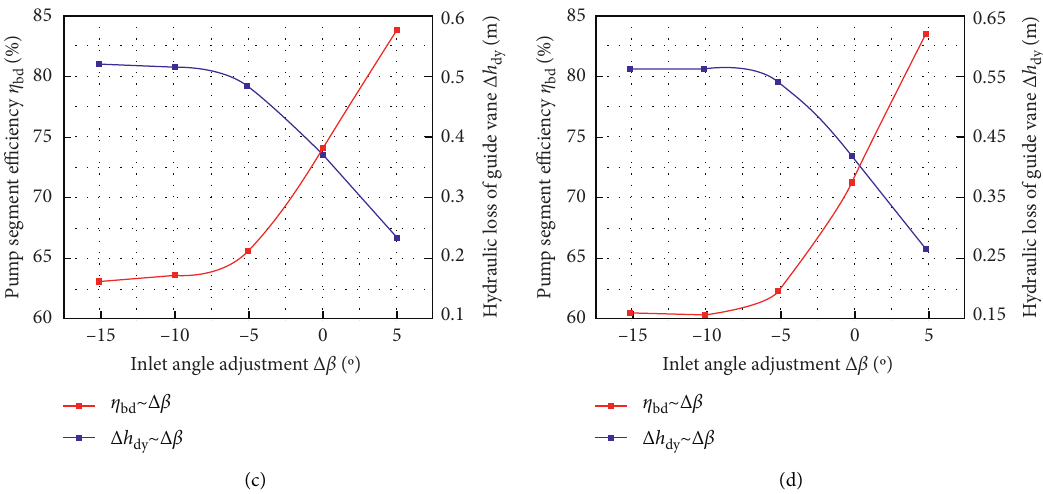
Figure 17: η h dy ∼ Δ β curves for different bd ∼ Δ β and Δ